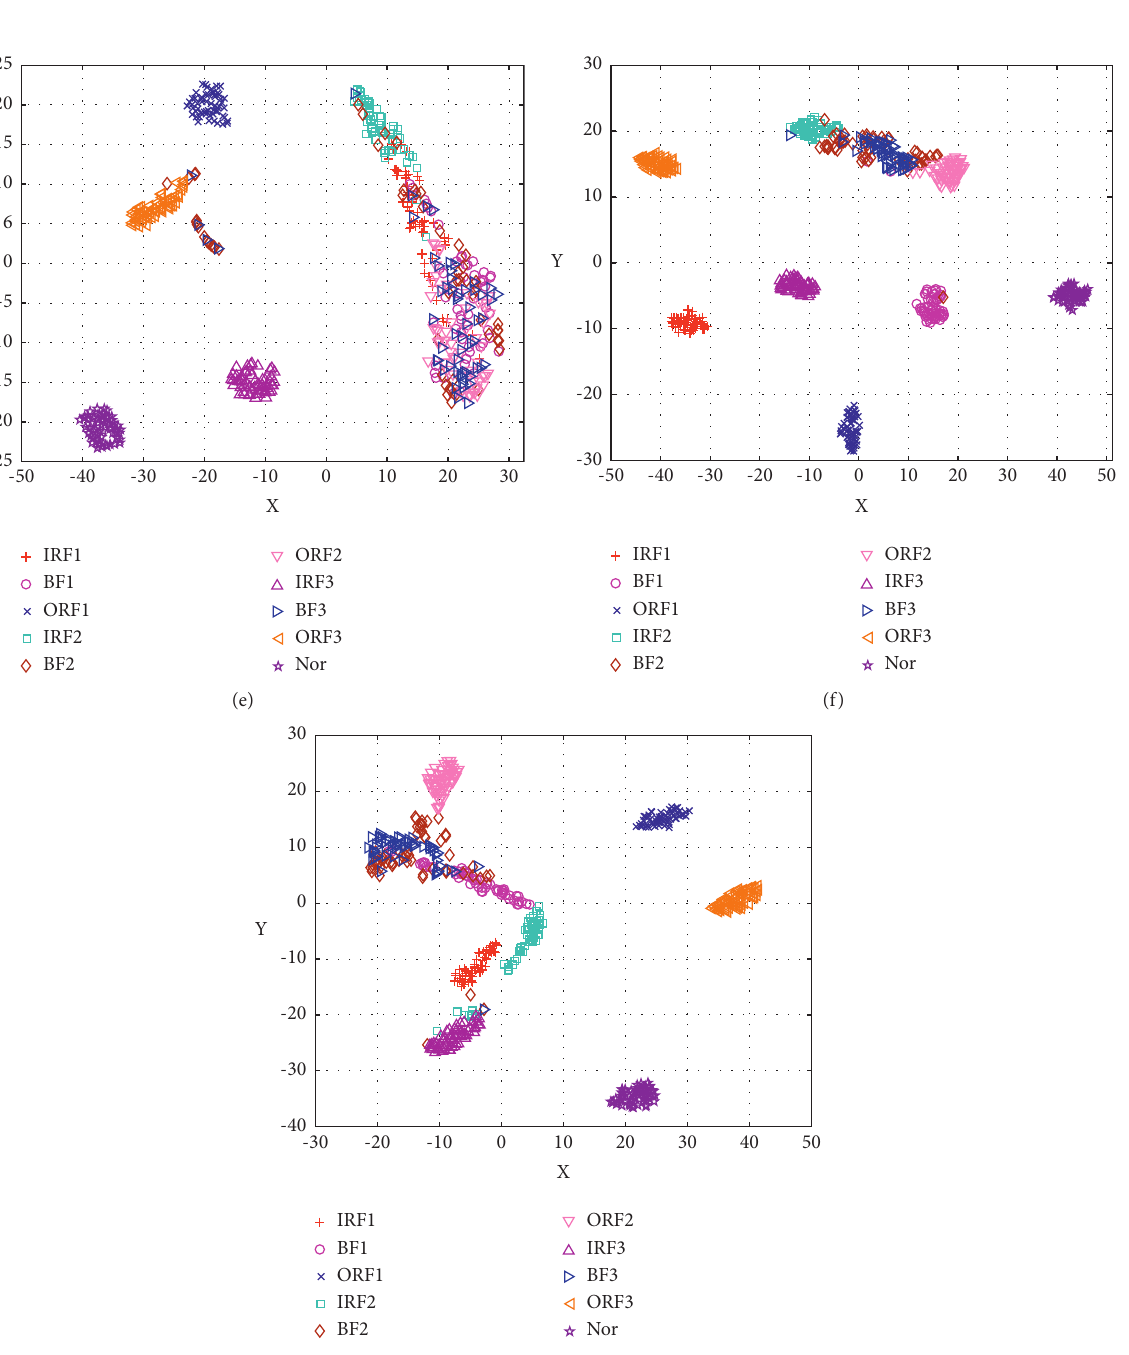
Figure 12: The two-dimensional feature visualization map obtained by